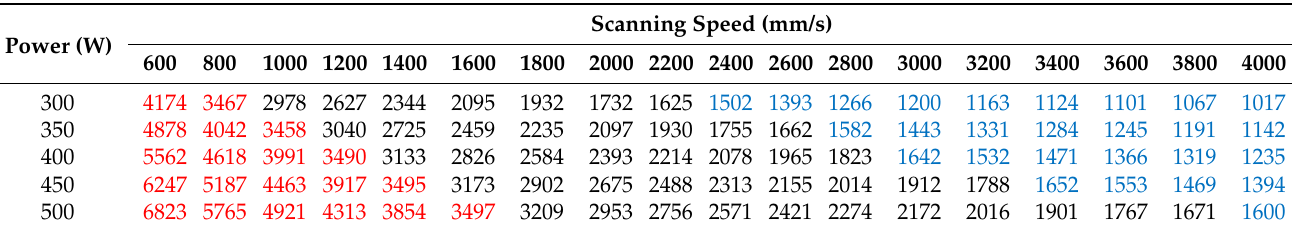
Figure 8. Temperature–time curves for: ( a ) different laser powers at a scanning speed of 1400 mm/s; ( b ) different scanning speeds at a laser power of 400 W. Table 2. Maximum temperature ( ◦ C) of melt pool with different process